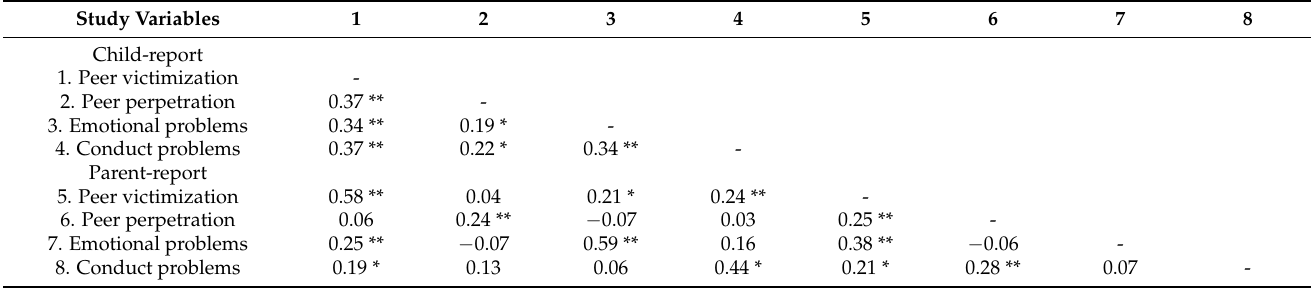
Table 3. Intercorrelations of key study variables across the peer sample ( n = 142).